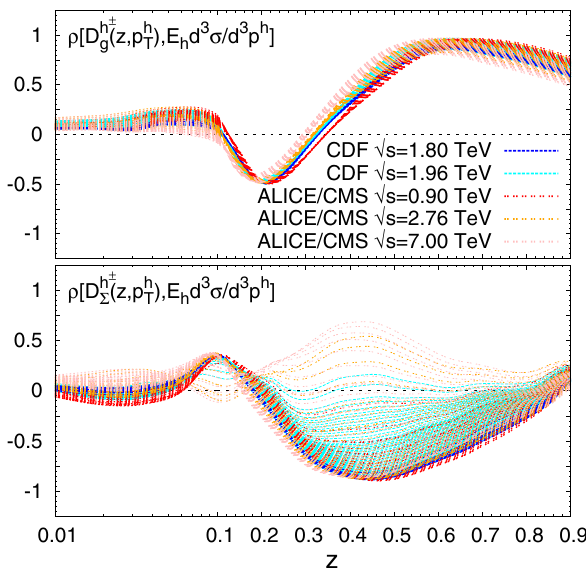
Fig. 1 The correlation coefficient ρ between the gluon (top) and the singlet (bottom) FFs from NNFF1.0h and the pp data listed in Table 1. Each data point corresponds to a separate curve; FFs are evaluated at a scale μ equal to the p h of that T